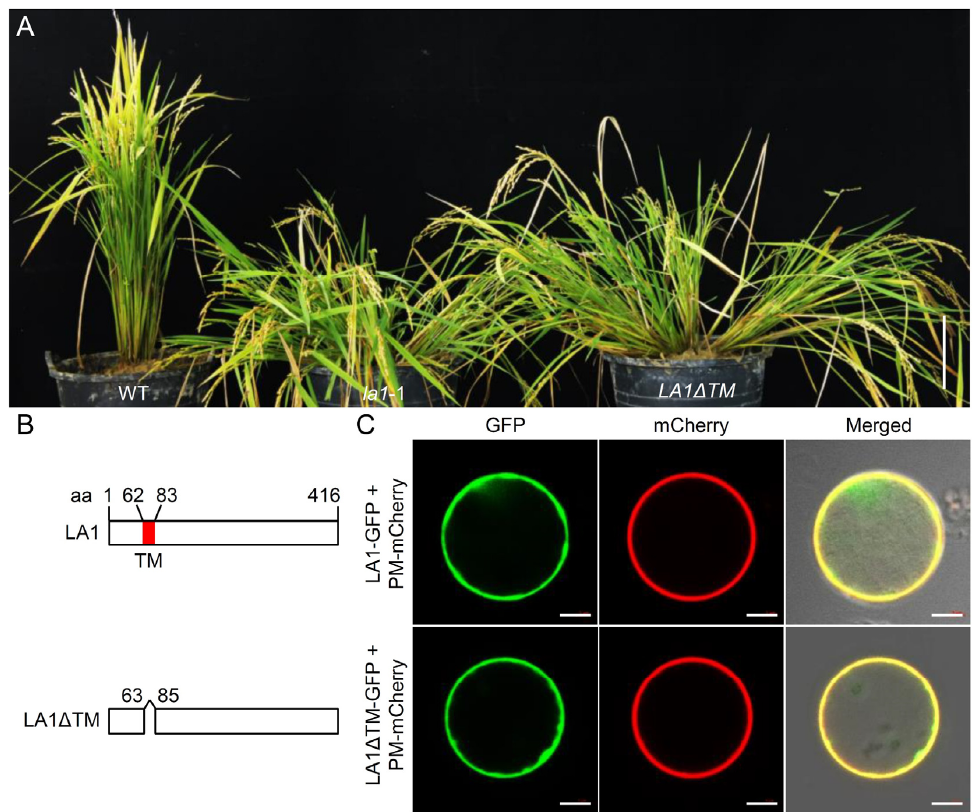
Figure 5. Effect of the TM domain on LA1 function. ( A ) Plant architectures of WT, LA1 -knockout ( la1 -1), and LA1-TM-absence ( LA1 Δ TM ) plants. TM, transmembrane. Scale bar, 10 cm. ( B ) Schematic diagram of LA1 and its truncated derivative LA1 Δ TM. The red region indicates the predicted TM domain. The folded line indicates the deleted region. aa, amino acid. ( C ) Localization of LA1-GFP and LA1 Δ TM-GFP to the plasma membrane. The LA1-GFP and LA1 Δ TM-GFP constructs were co-expressed with the plasma-membrane-localized PM-mCherry construct in rice protoplasts, respectively. Scale bars, 10 μ m.